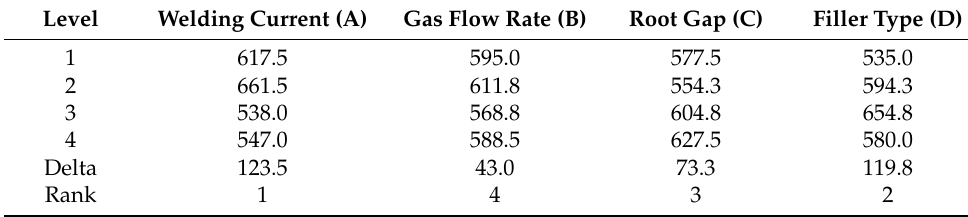
Table 16. Response table for means of Flexural Strengths.